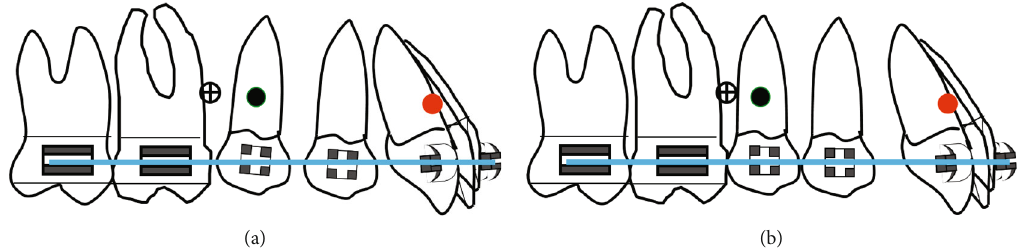
Figure 4: (a) At that stage the microimplant is displaced distally according to its initial angulation, if it is parallel to the long axis of the tooth there is no need to displace it, if it is perpendicular to the bone surface, it is recommended to relocate it distally to avoid any contact with the premolar roots; then, the premolars are bonded and leveled. (b) Uprighting of premolars and space closure